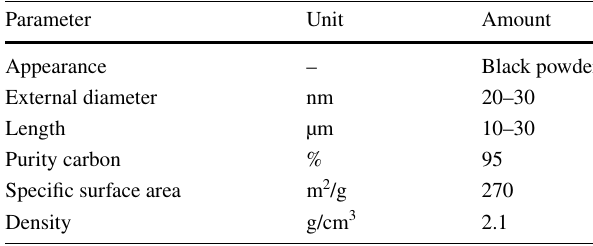
Table 1 The physical specifications of